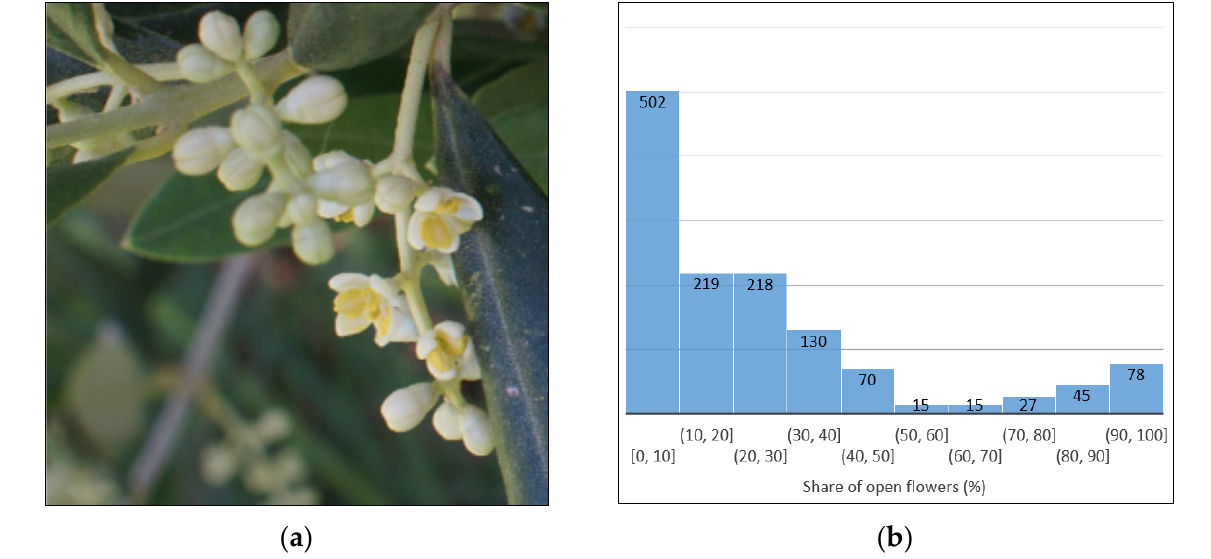
Figure 2. Olive flowering phenophases dataset ( a ) Sample image; ( b ) Distribution of the share (percentage) of open flowers for all images in the dataset.